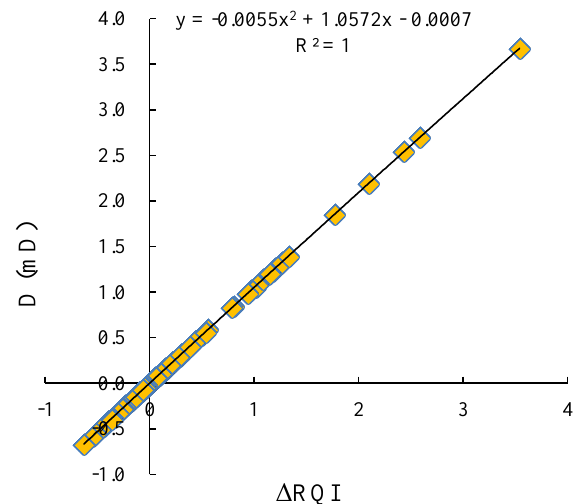
Figure 5. The cross-plot between D and ΔRQI. The highest polynomial correlation coefficient is 1 when m is 1.02 and n is 0.03.